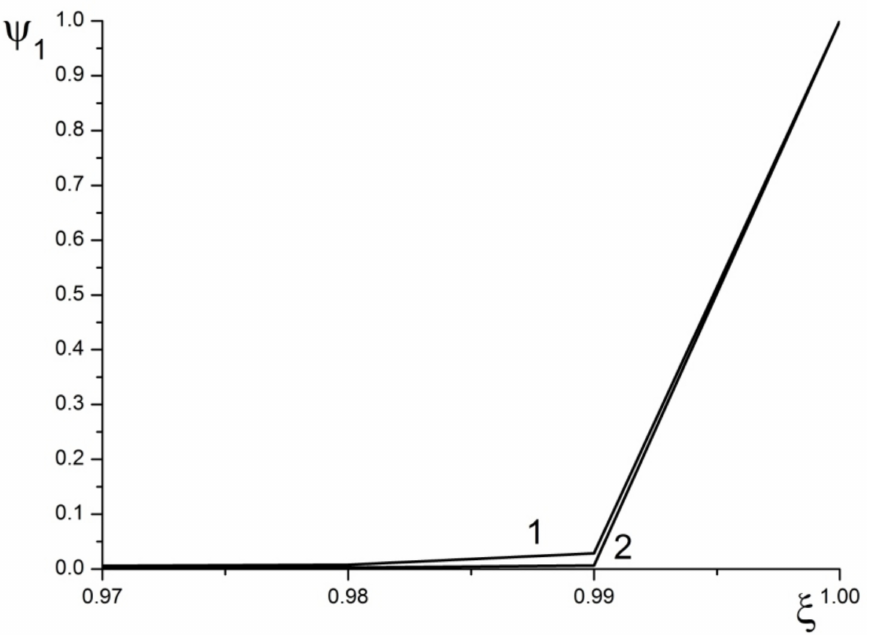
Figure 9. The integrals Ψ 1 ( ξ ) for the Figure 8 solutions. Approximate model (29). A = 2.75 × 10 − 18 ; Ar = 0.012; h s = 7.14 × 10 2 ; µ = 75.0; g = 1.22 × 10 − 20 ; θ s = 87.70; 1—Pe = 50.0; 2—Pe =